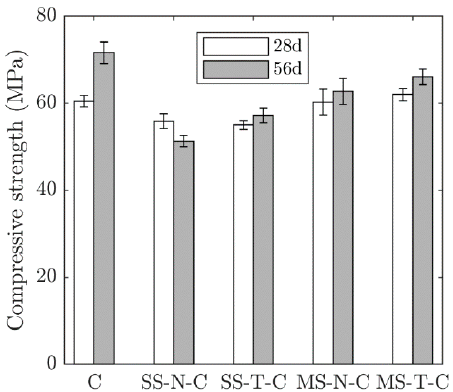
Figure 4. Compressive strengths of the specimens. The control chloride-resistant high-performance concrete was denoted by C. The chloride-resistant small-size coarse aggregate concrete spacers and the chloride-resistant mortar spacers were denoted by SS and MS, respectively. The composite specimen with and without surface treatment were denoted by T and N, respectively.